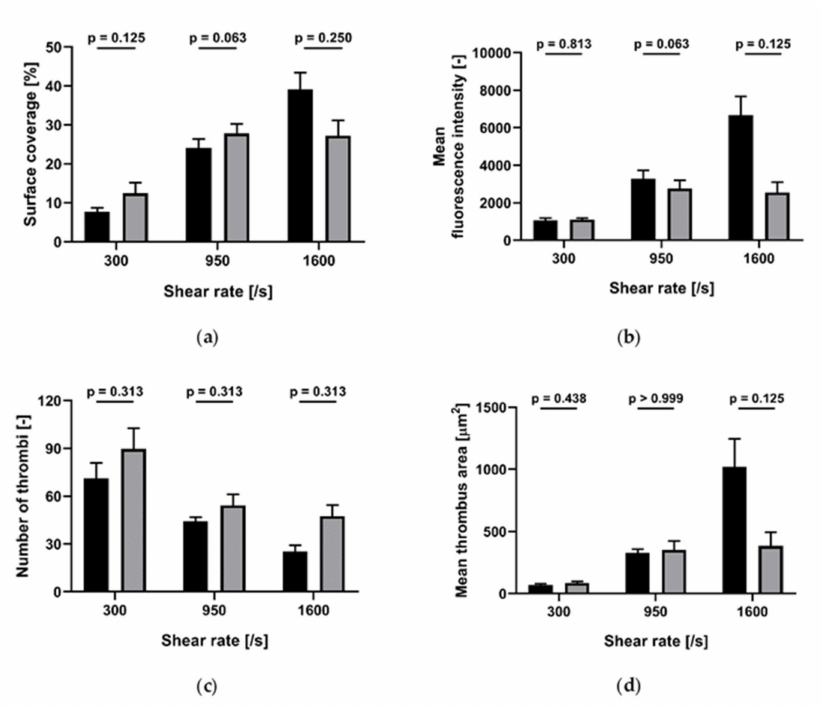
Figure 7. E ff ect of cangrelor at di ff erent shear rates on platelet accumulation on collagen (100 µ g / mL)-coated m ( n = 5). Black: without cangrelor; grey: with cangrelor added in vitro. ( a ) Surface coverage; ( b ) mean fluorescence intensity; ( c ) number of thrombi; ( d ) mean thrombus area. Data are represented as column bar graphs, with means ± standard errors of the mean, and analyzed by Wilcoxon matched